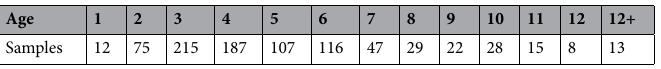
Table 1. Sample size per age category.